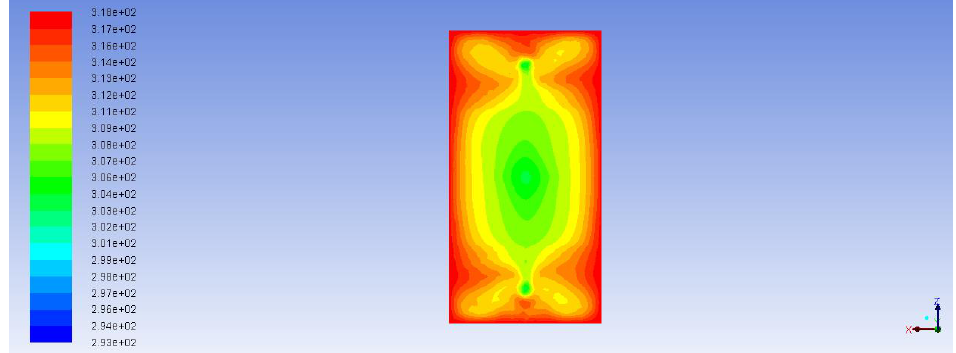
Figure 15. Temperature profile (XZ middle cross section, the reactor walls and the catalyst boundary are not shown, color map is indicated in K units).